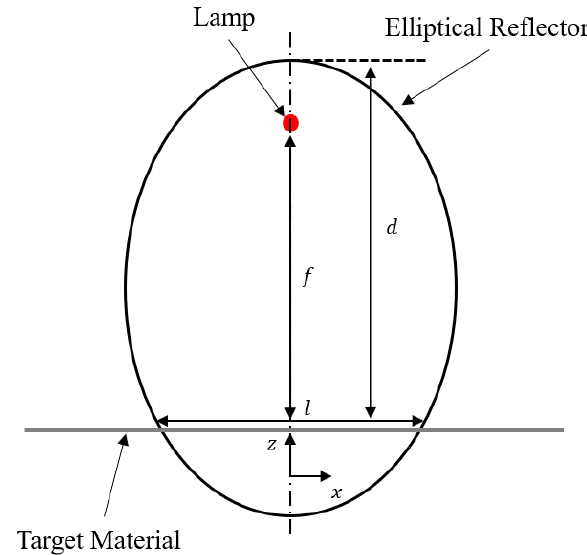
Figure 2. Geometrical parameter of the elliptical reflector.